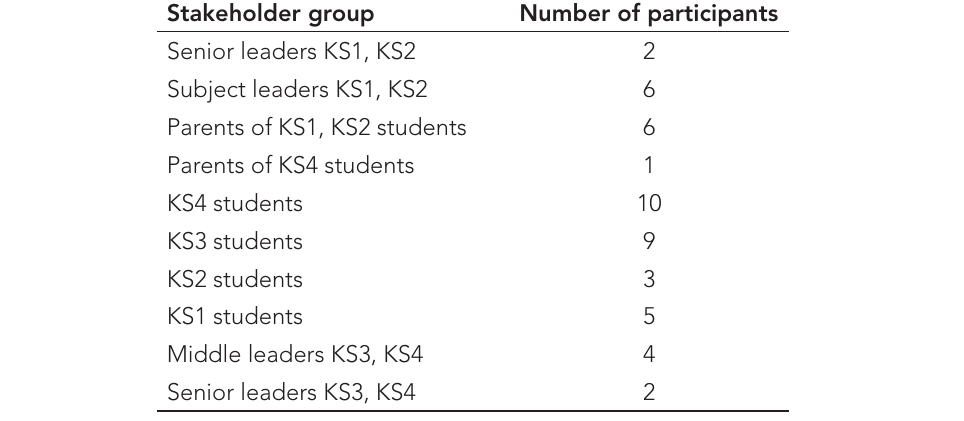
Table 2: Stakeholder